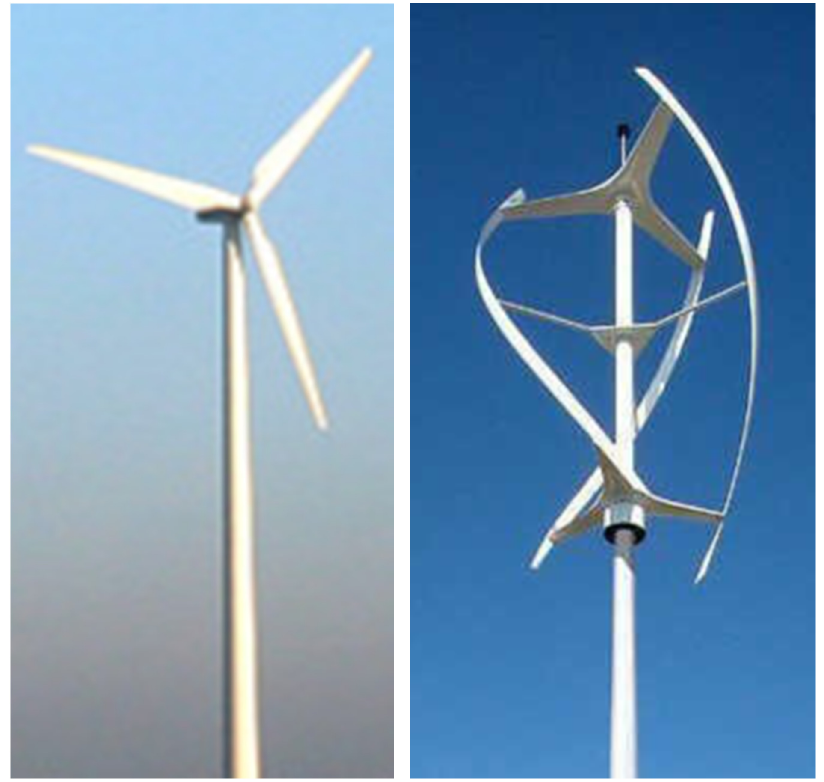
Figure 3. Different types of small wind turbines.